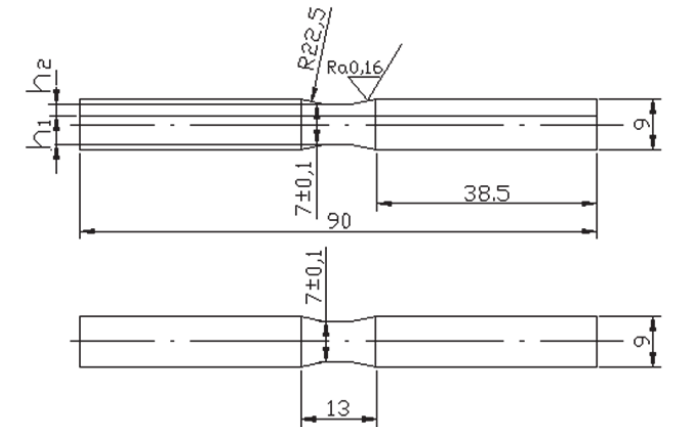
Figure 2: Shape and dimensions of specimen (in mm).